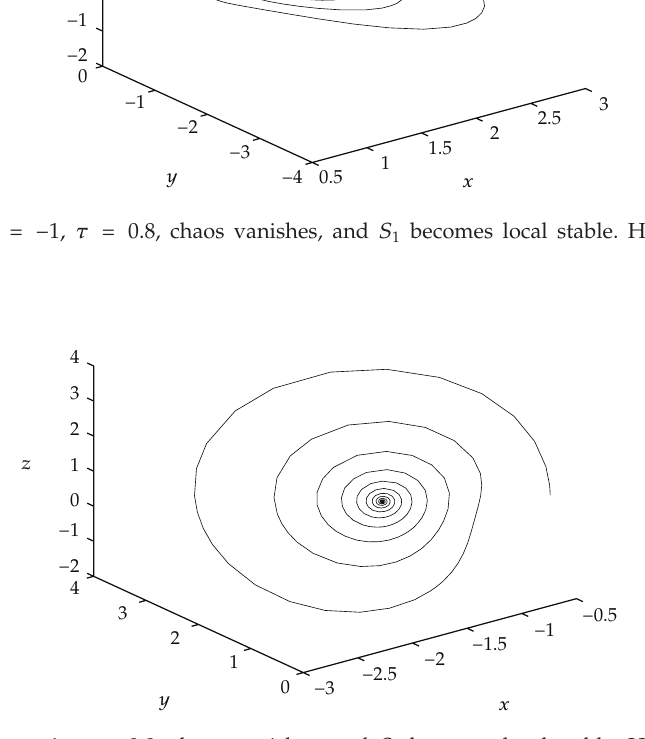
Figure 5: When K (cid:7) − 1 , τ (cid:7) 0 . 8, chaos vanishes, and S 2 becomes local stable. Here initial value is (cid:3) − 0 . 5 , 0 . 5 , 0 . 6 (cid:4) .